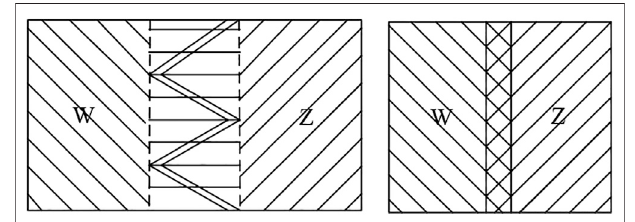
FIGURE 2 | Coupling bene fi t relationship of